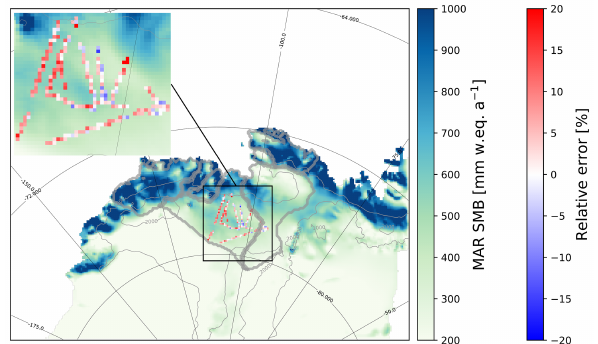
Figure 3. Annual mean (1979–2017) simulated SMB (blue–green scale) and relative error of the simulated SMB compared to the airborne-radar data from Medley et al. (2013, 2014) (blue–red color bar). Grey contours indicate the surface height (every 1000m). The drainage basins under consideration are the same as in Fig. 1 (large grey contours